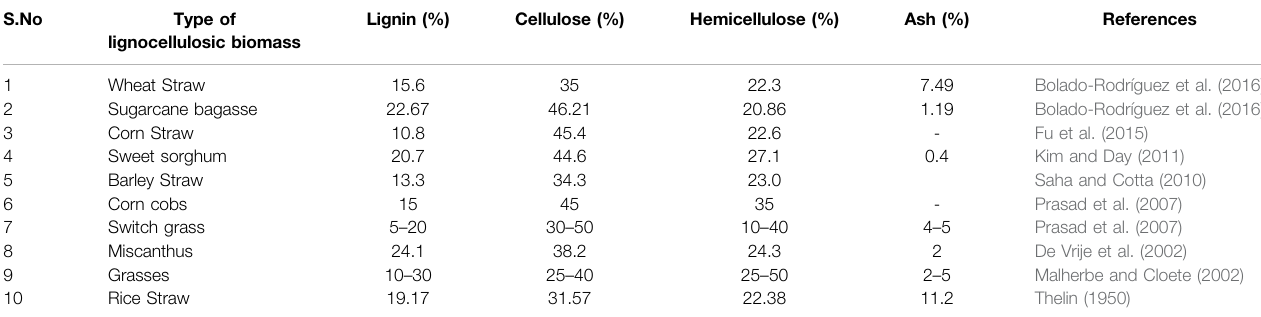
TABLE 1 | Compositional Analysis of various lignocellulosic